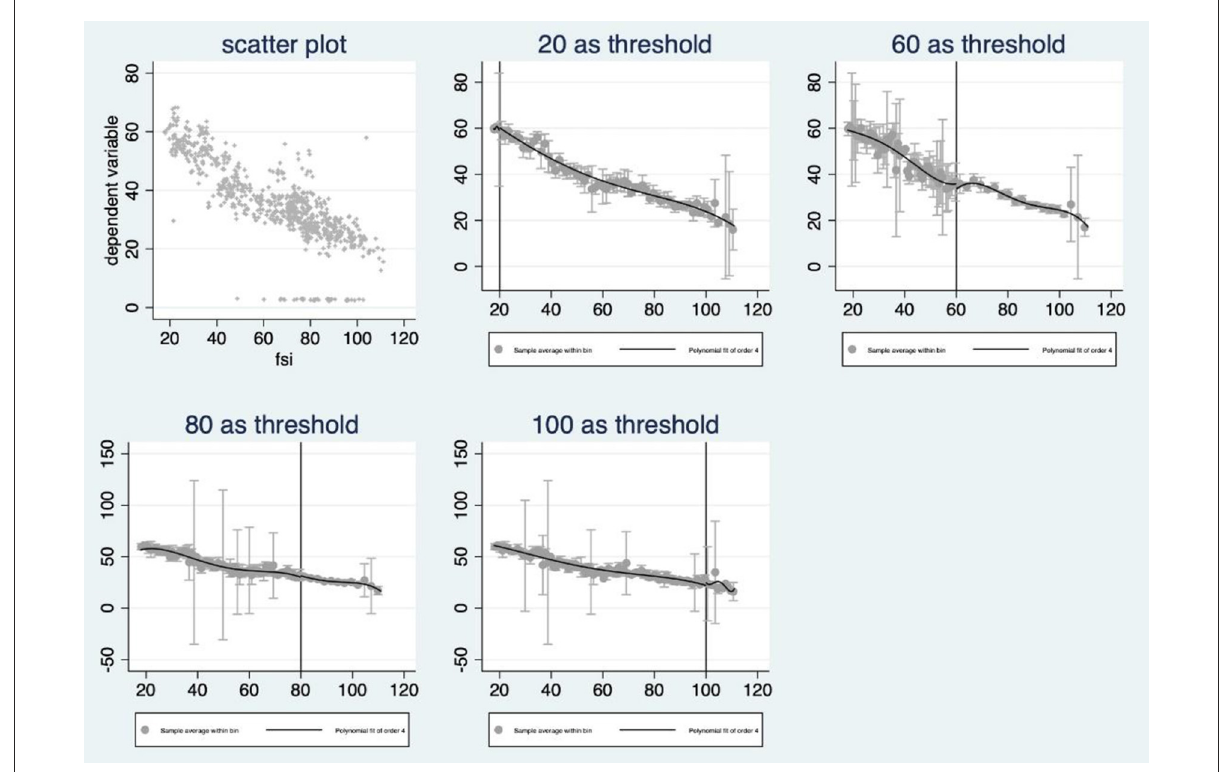
FIGURE1 General scatter and fitting results with different thresholds.